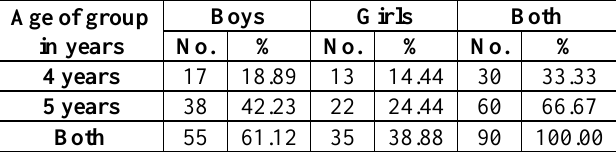
Table 1: Distribution of Sample According to Age and Gender